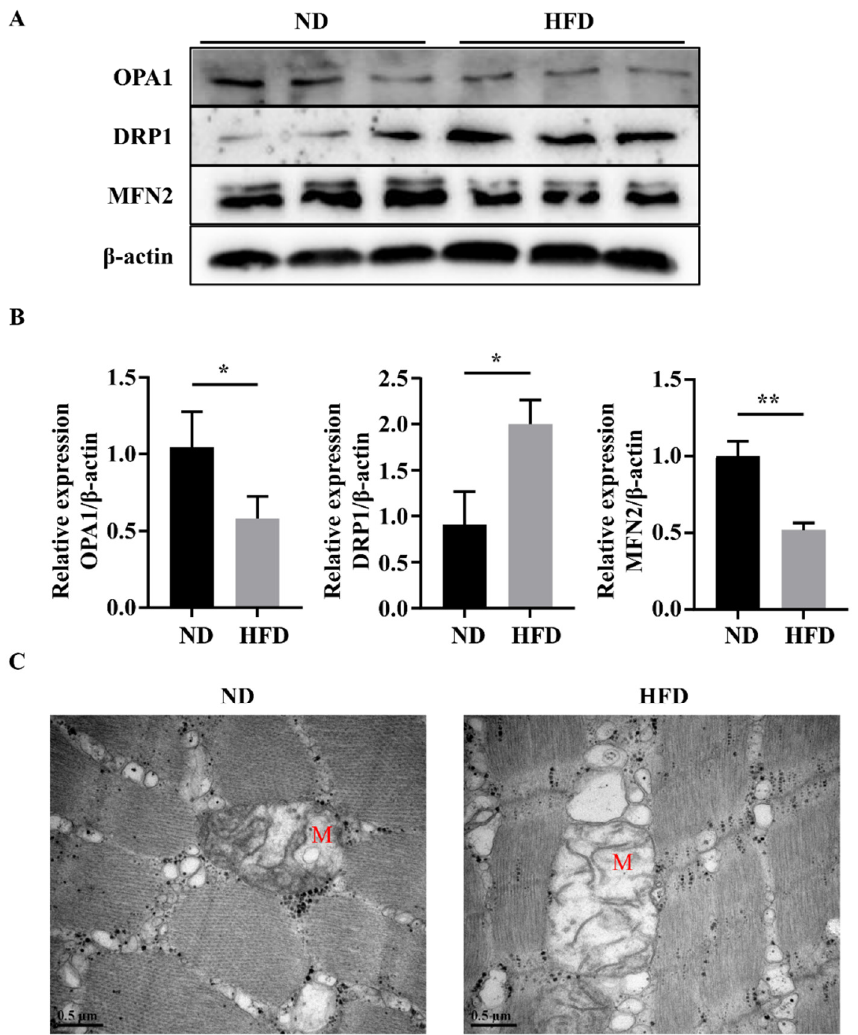
Figure 5. Long-term HFD feeding induced abnormal mitochondrial fusion and fission. ( A , B ) Protein expression of OPA1, MFN2, and DRP1. ( C ) Representative photomicrographs of muscle sections imaged using transmission electron microscopy. M, mitochondria. *, p < 0.05, **, p < 0.01. Data represent means, and error bars represent standard errors of the means. Scale bar in transmission electron microscopy images, 0.5 µ m. ND, normal diet; HFD, high-fat diet.